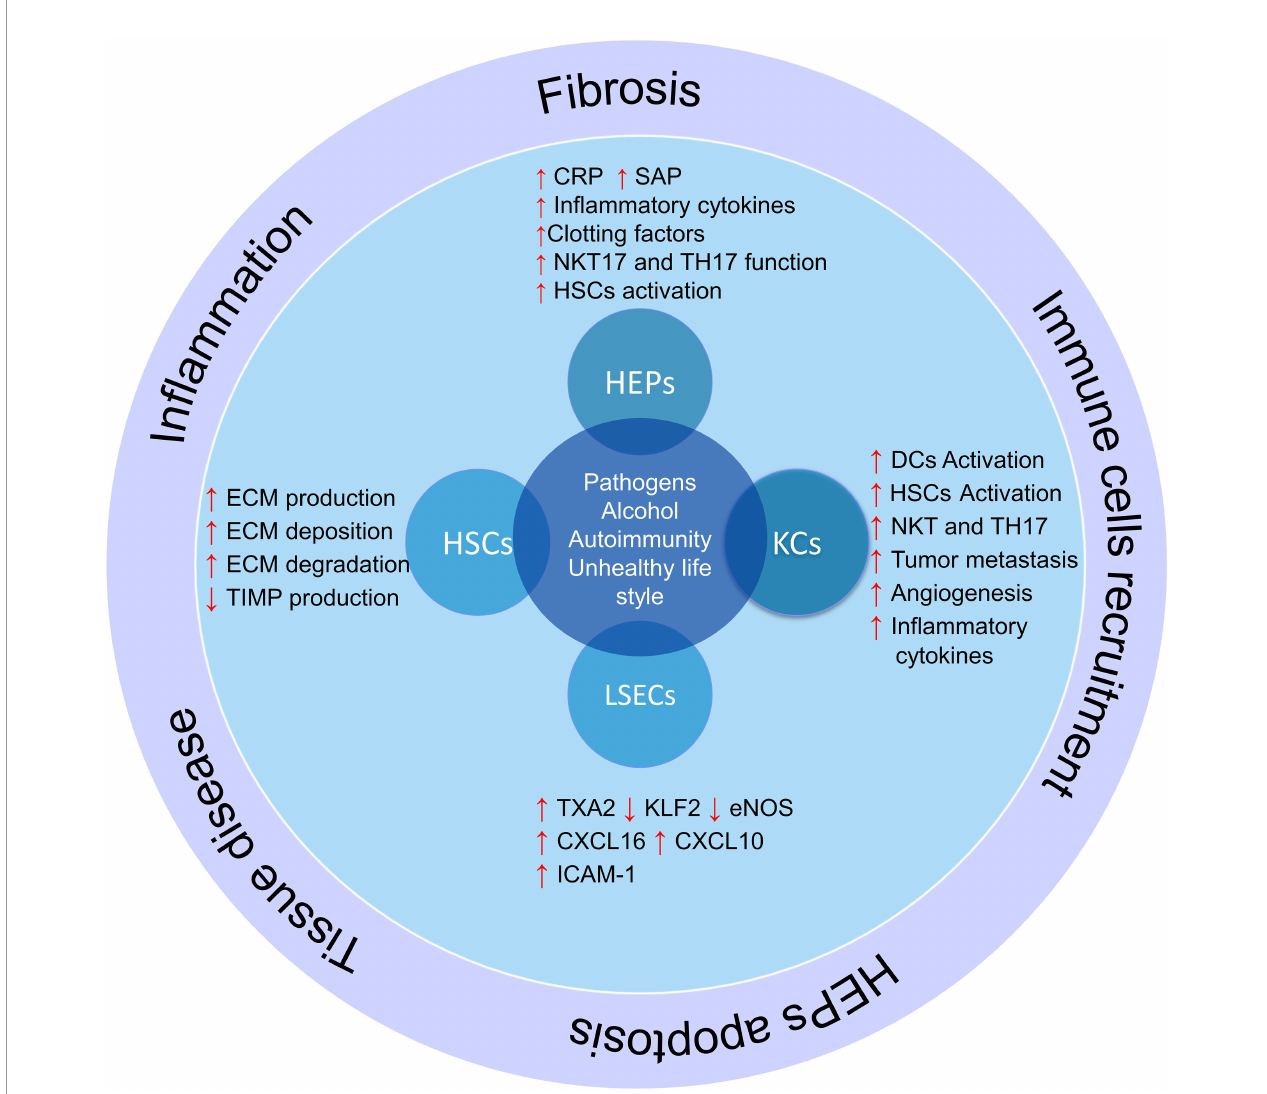
FIGURE 2 | The role of liver cells in in fl ammation and liver damage. Liver cells help produce and activate immune cells by producing cytokines and in fl ammatory chemokines. On the other hand, hepatic stellate cells produce fi brosis of the liver tissue and lose their function by producing different components of the extracellular matrix and differentiation into myo fi broblasts in in fl ammatory conditions; HSCs, hepatic stellate cells; KCs, Kupffer cells; LSECs, hepatic sinusoidal endothelial cells; HEPs, Hepatocytes; DCs, Dendritic cells; ECM, extracellular matrix; TXA2, Thromboxane A2; KLF2, Krüppel factor 2 transcription factor; TIMP, Tissue inhibitors of matrix